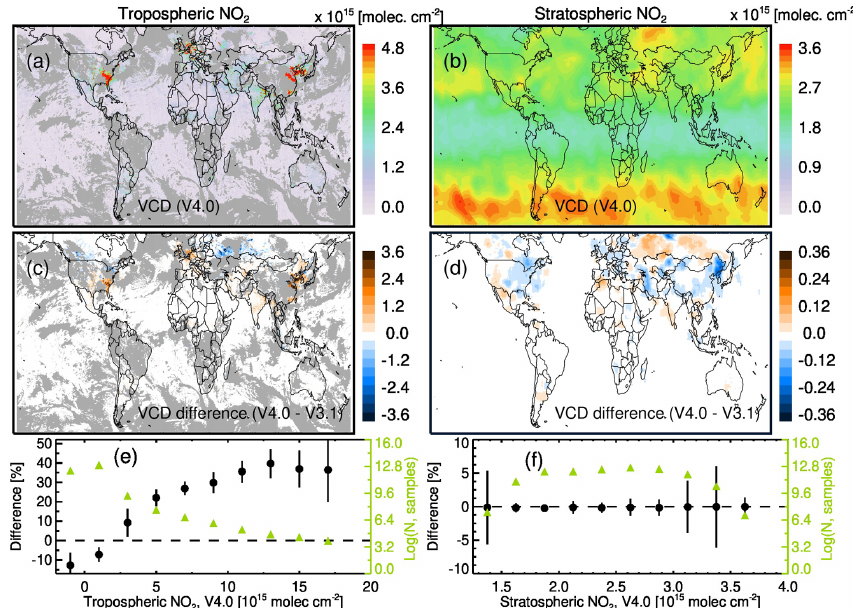
Figure 8. Tropospheric (a) and stratospheric (b) NO 2 VCD from V4.0 and their differences (c, d) with respect to V3.1 data (V4.0–V3.1) for 20 March 2005. Gray in the tropospheric NO 2 maps represents cloudy areas (CRF > 0.5). Bottom panels show the average (black circles) and standard error (vertical bars) of the relative difference, 100 × (V4.0–V3.1) / V3.1, for tropospheric (e) and stratospheric (f) NO 2 VCDs plotted as a function of the respective NO 2 column amounts. The green symbols represent the logarithm of the number of samples.